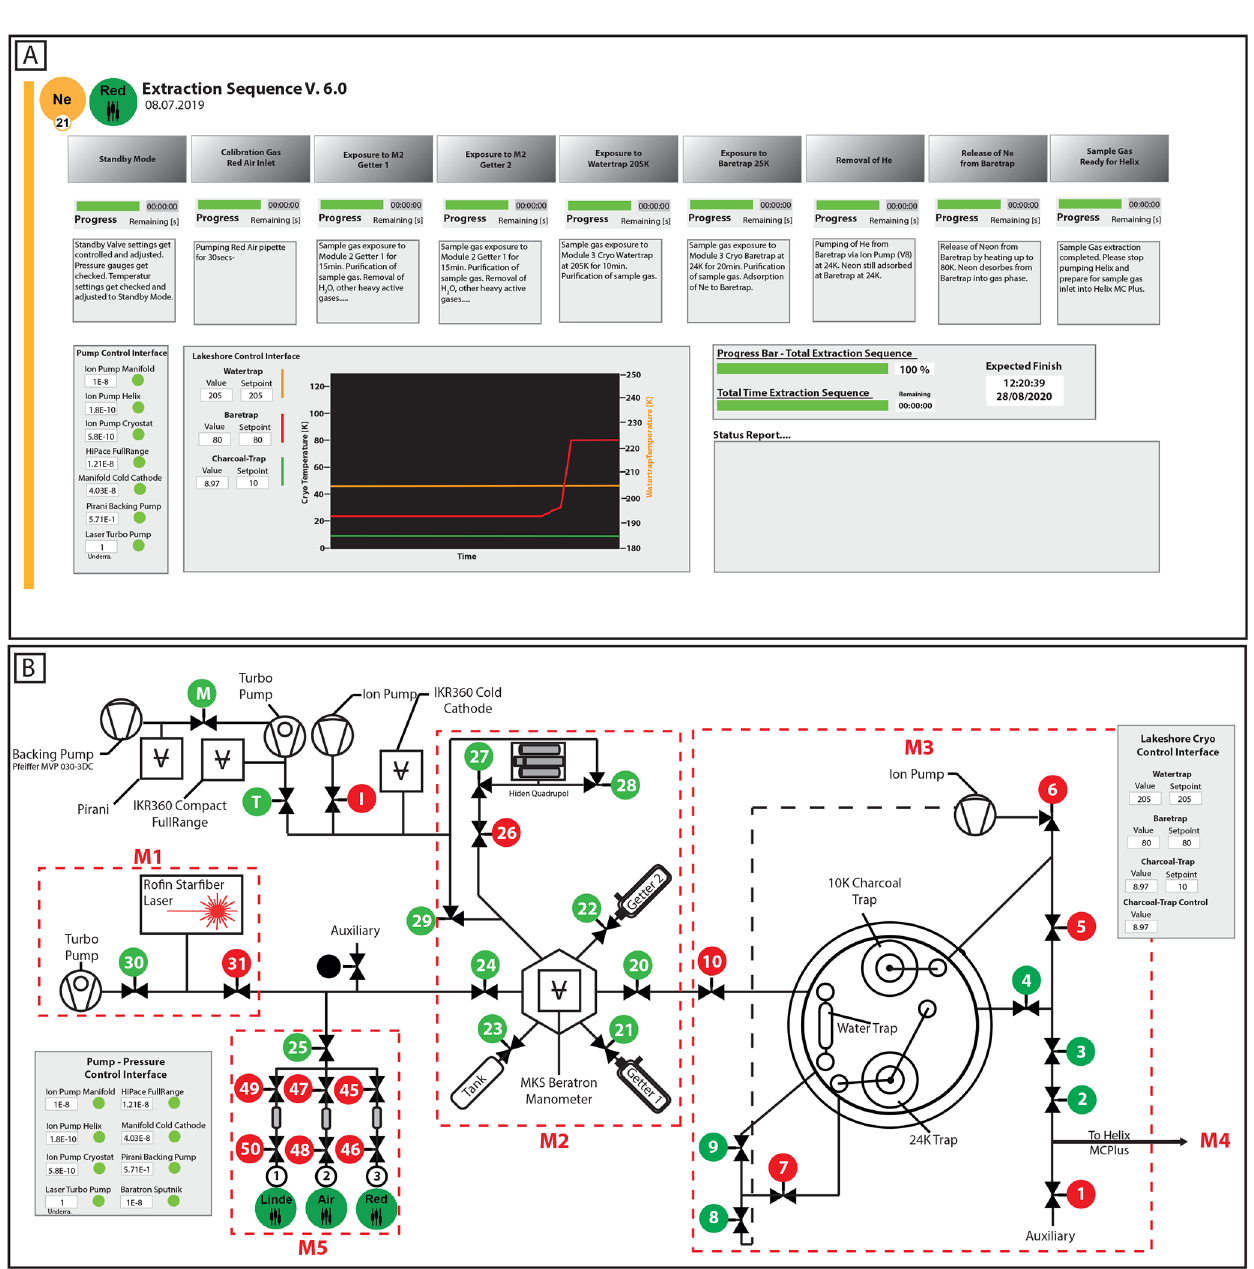
Figure 3. Screenshots of the operating VI program interface of the Cologne (CGN) Noble Gas Helix MC Plus. (a) The neon VI informs the user in real time about current data, such as pressure and temperature, as well as about the current status of the preparation. (b) Valve circuit overview. M1–M5 indicate the different modules of the extraction line. Valve numbers (1–10, 20–31, M, T, I) are coloured depending on the current state (green = open, red =